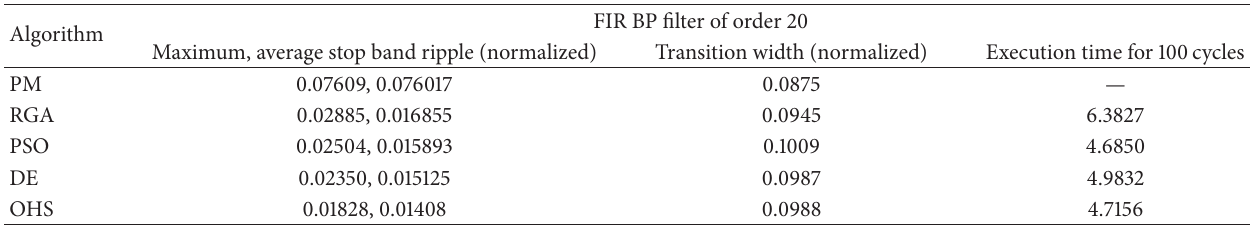
Table 9: Other comparative results of performance parameters of all algorithms for the FIR BP filter of order 20.